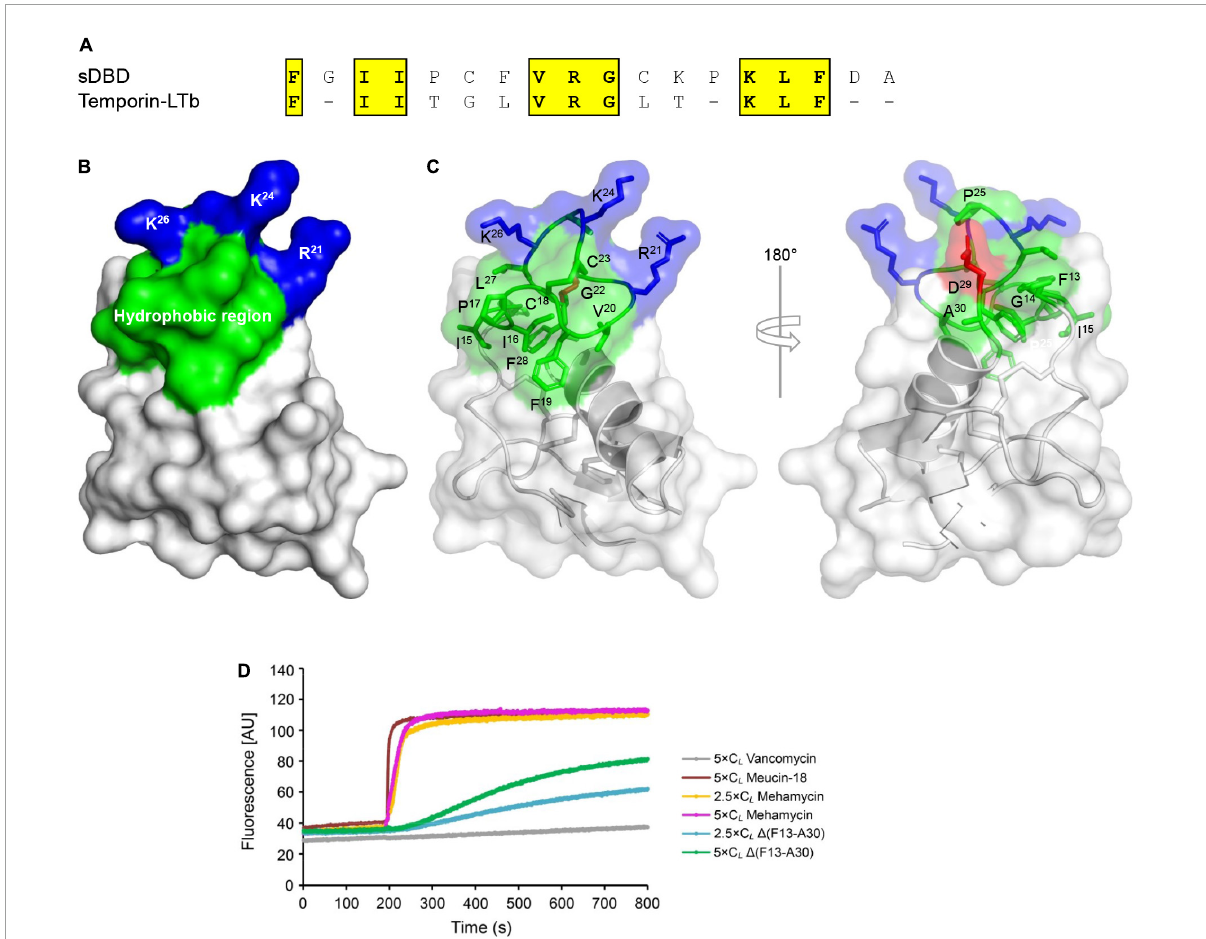
FIGURE4 Sequence and structural bases of the membrane-disruptive ability of mehamycin. (A) Alignment of sDBD with a representative cationic lytic amphipathic peptide (Temporin–LTb) from frog skin. Identical amino acids are shaded in yellow. (B,C) The sDBD presents a typical local amphipathic architecture. The structure is shown as cartoons in a transparency mode in which residues involved in amphipathy are shown as sticks and colored in blue (basic), green (hydrophobic), and red (acidic), respectively. (D) Comparison of bacterial membrane permeation ability between mehamycin and (cid:49) (F13-A30). Mehamycin and (cid:49) (F13-A30) at 2.5 × or 5 × C L was added when the basal fluorescence remained constant for 200 s. Vancomycin (C L : 0.119 µ M) and Meucin-18 (C L : 0.25 µ M) were used as negative and positive